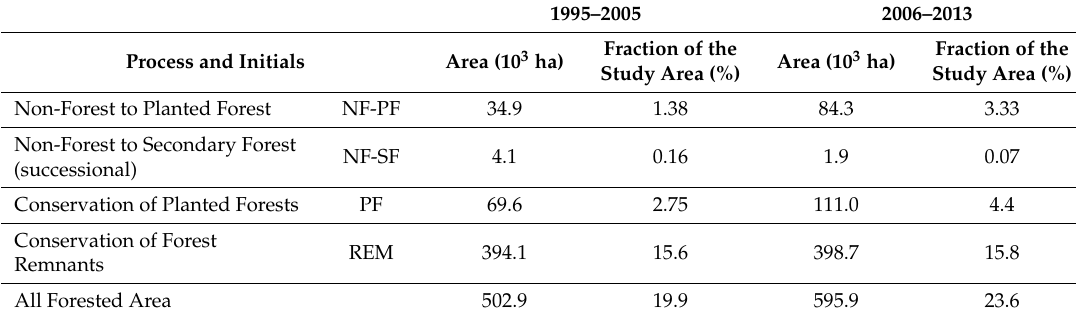
Table 3 . Areas corresponding to the main forest cover transitions from Figures 2 and 3. Table 3. Areas corresponding to the main forest cover transitions from Figures 2 and